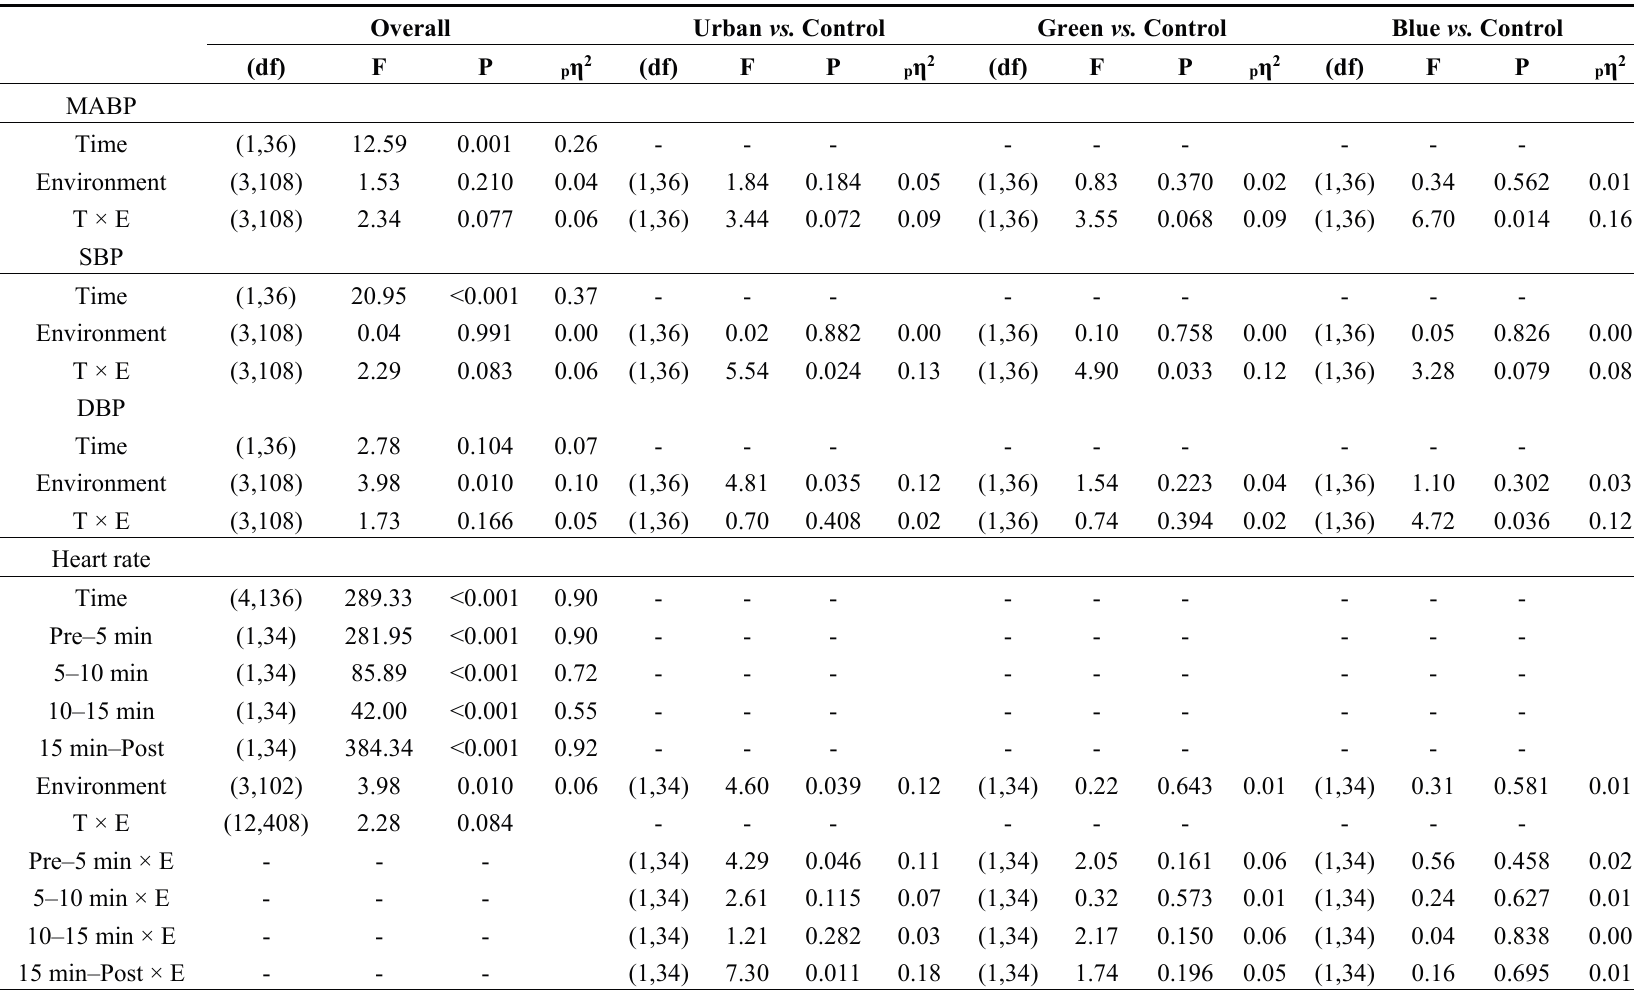
Table 3. Results of ANOVAs with planned contrasts for physiological variables: Repeated for Time, Simple for Environment (with Control as comparator), and Repeated × Simple for Time by Environment. Overall Urban vs. Control Green vs. Control Blue vs.